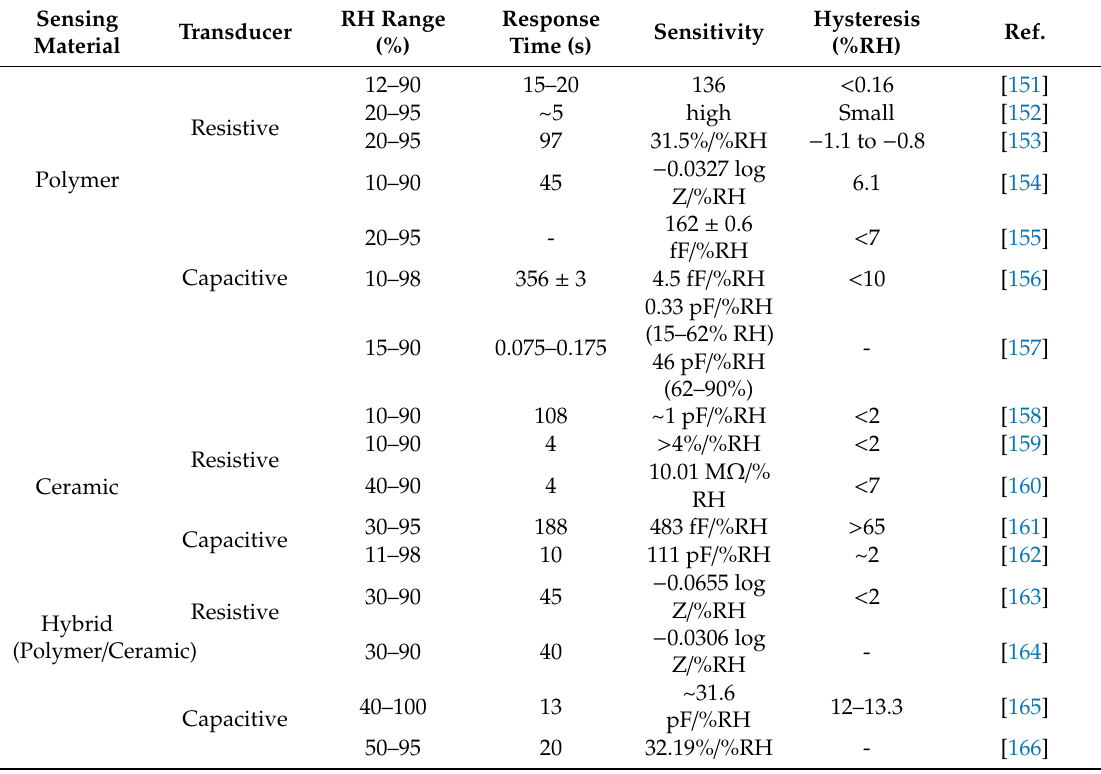
Table 5. Specification of thin film / membrane humidity